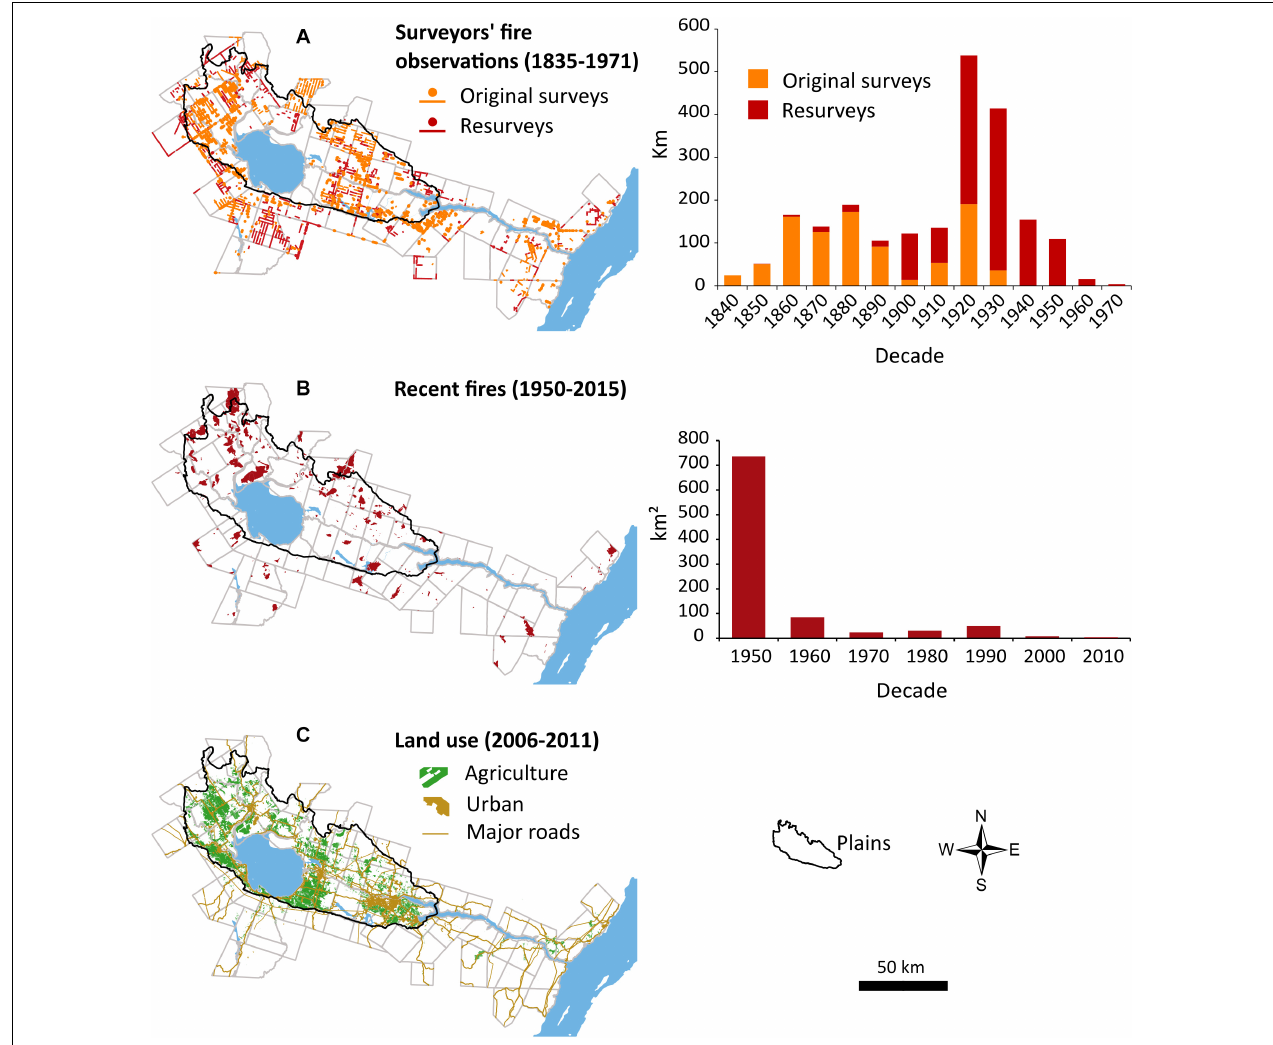
FIGURE 2 | Maps showing (A) surveyor’s fire observations (points and lines) tallied from logbooks of original surveys and resurveys, (B) distribution and size of recent fires from mapped fire polygons, and (C) present-day land use in the study area. Histograms represent kilometers of fire along range lines (surveyor’s observations) and burned areas (recent fires) by